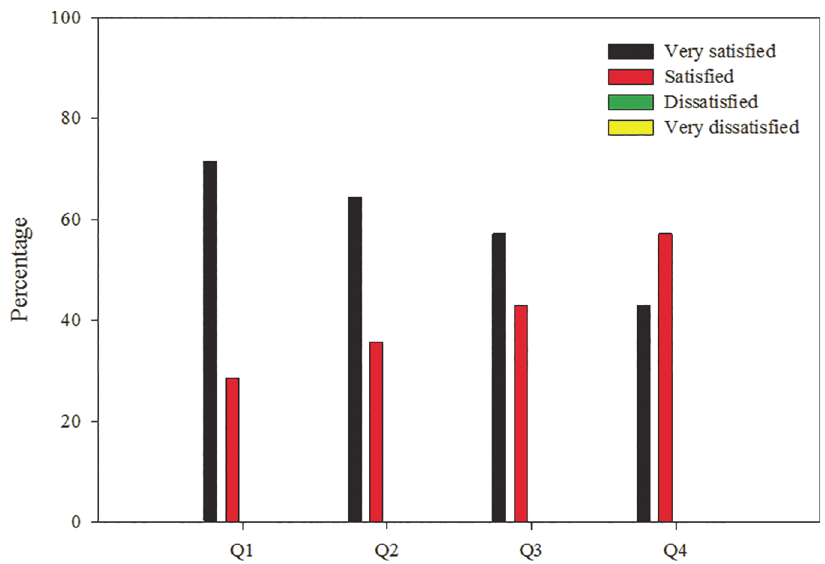
Fig 1. Participant written evaluation responses to questions focused on the overall workshop experience. Q1: Overall, how satisfied were you with the speakers/presenters?; Q2: Overall, how satisfied were you with the workshop facilities?; Q3: Overall, how satisfied were you with the laboratory information presented?; Q4: Overall, how satisfied were you with the workshop organization?